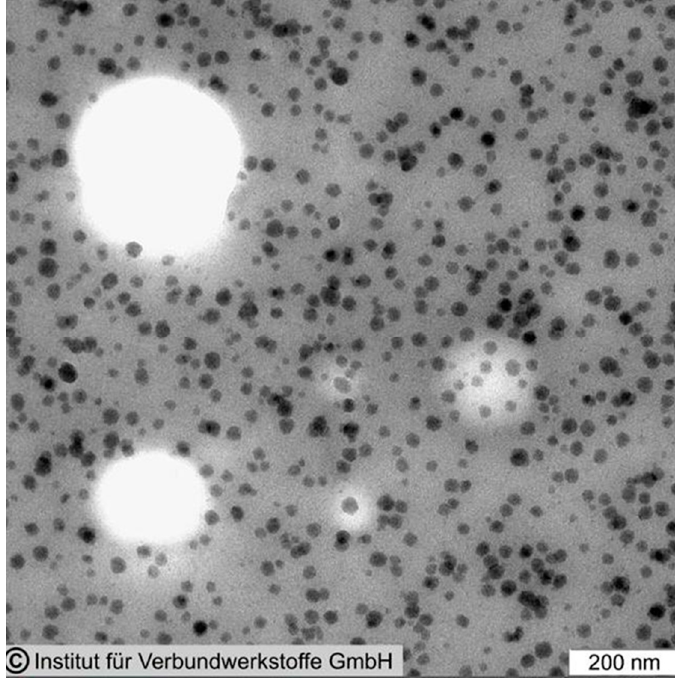
Figure 10. TEM picture of DGEBA modified with core shell rubber (CSR Type III) and nanosilica [24].